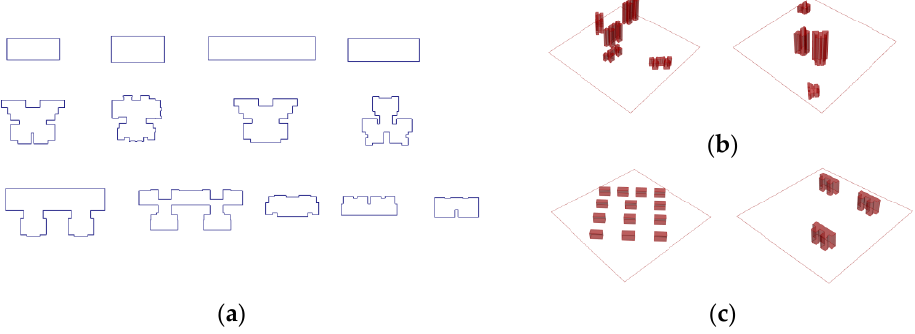
Figure 3. Architectural form generation case schematic: ( a ) 13 commonly used residential building contours; ( b ) first residential area form with free layout; ( c ) second architectural form with determinant layout.